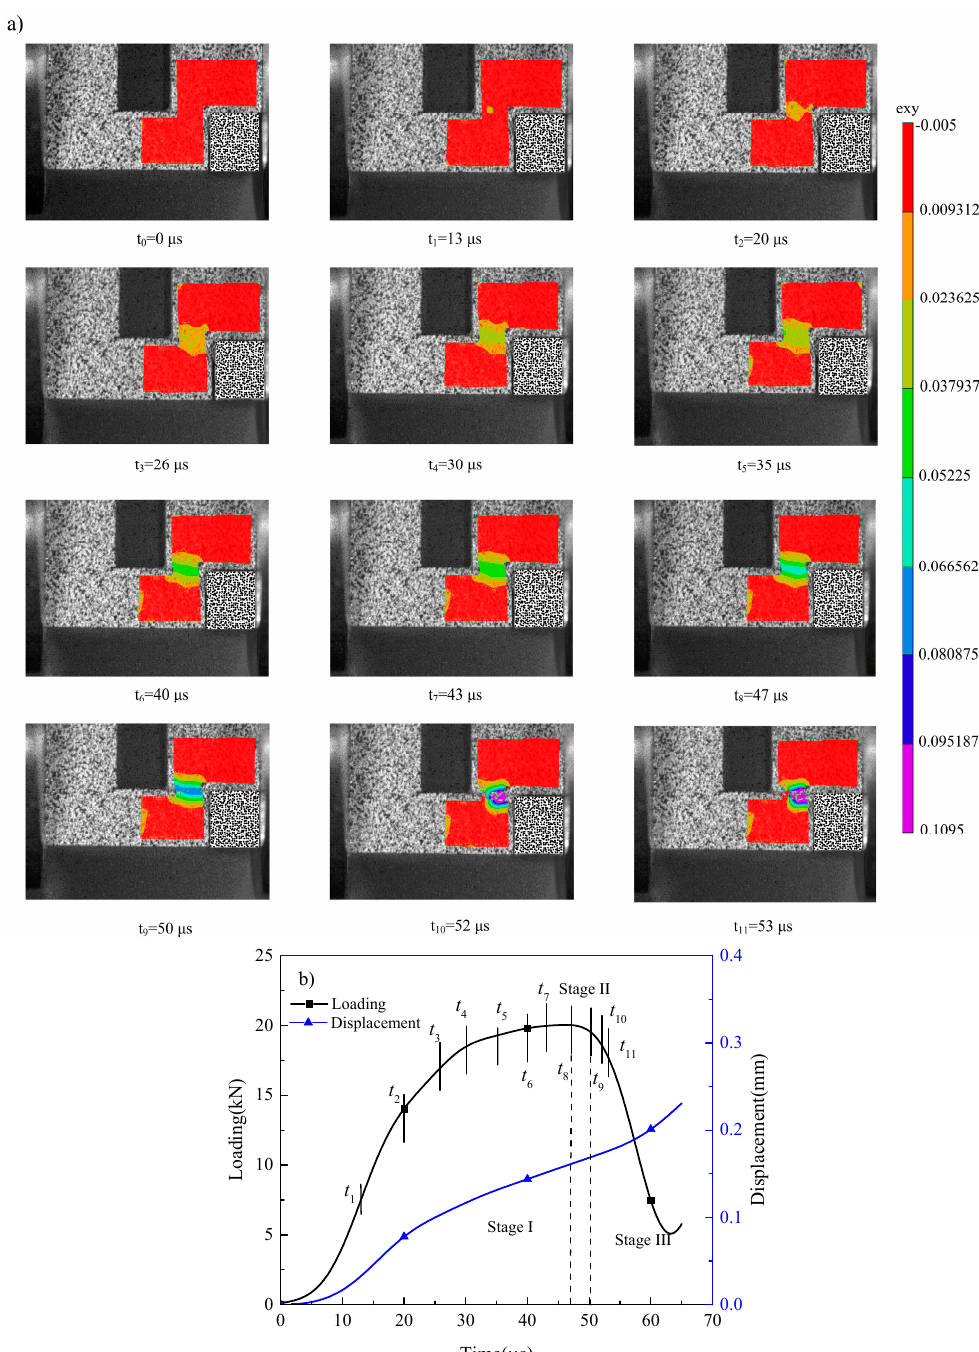
Figure 6. Tensorial shear strain field evolution of Ti-55511 alloy loaded at 9.2 m/s: ( a ) strain field at different time; ( b ) loading and displacement vs. time.